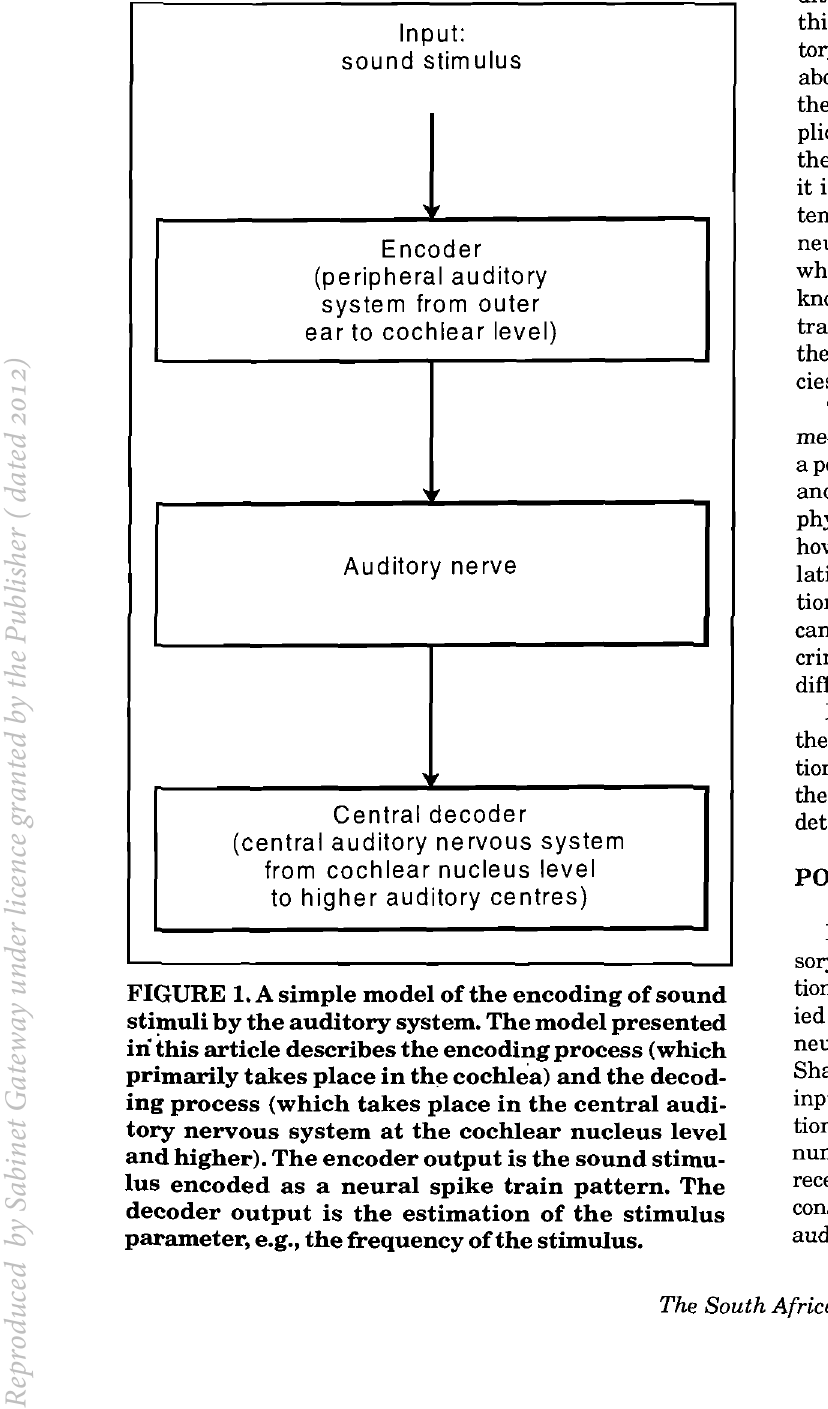
FIGURE 1. A simple model of the encoding of sound stimuli by the auditory system. The model presented hi ihis article describes the encoding process (which primarily takes place in the cochlea) and the decod ing process (which takes place in the central audi tory nervous system at the cochlear nucleus level and higher). The encoder output is the sound stimu lus encoded as a neural spike train pattern. The decoder output is the estimation of the stimulus parameter, e.g., the frequency of the